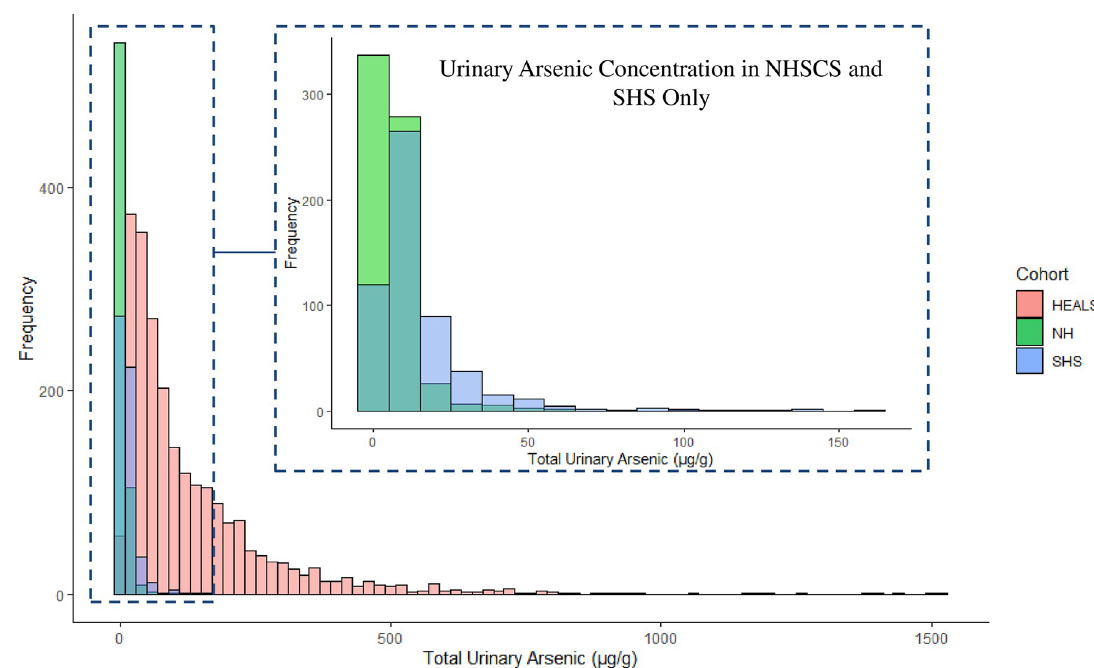
Fig 1. Urinary arsenic concentrations in HEALS, NHSCS, and SHS. Distributions of total urinary arsenic ( μ g/g of creatinine) are shown for three arsenic-exposed populations: The Health Effect of Arsenic Longitudinal Study (HEALS, in red), the New Hampshire Skin Cancer Study (NHSCS, in green), and the Strong Heart Study (SHS, in blue). The inset Fig shows SHS and NHSCS only.